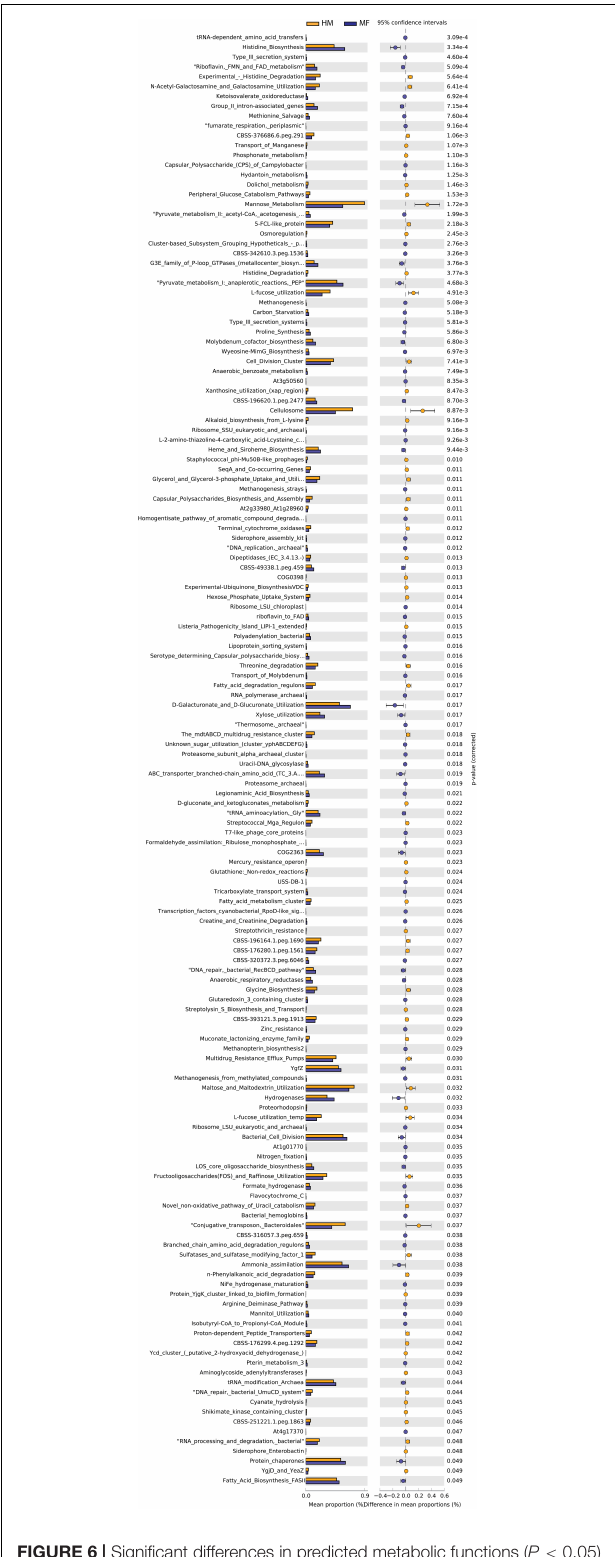
FIGURE 6 | Significant differences in predicted metabolic functions ( P < 0.05) for distal colon bacterial gene profile detected at PND 51 in male piglets fed with HM or MF from day 2 until day 21 of